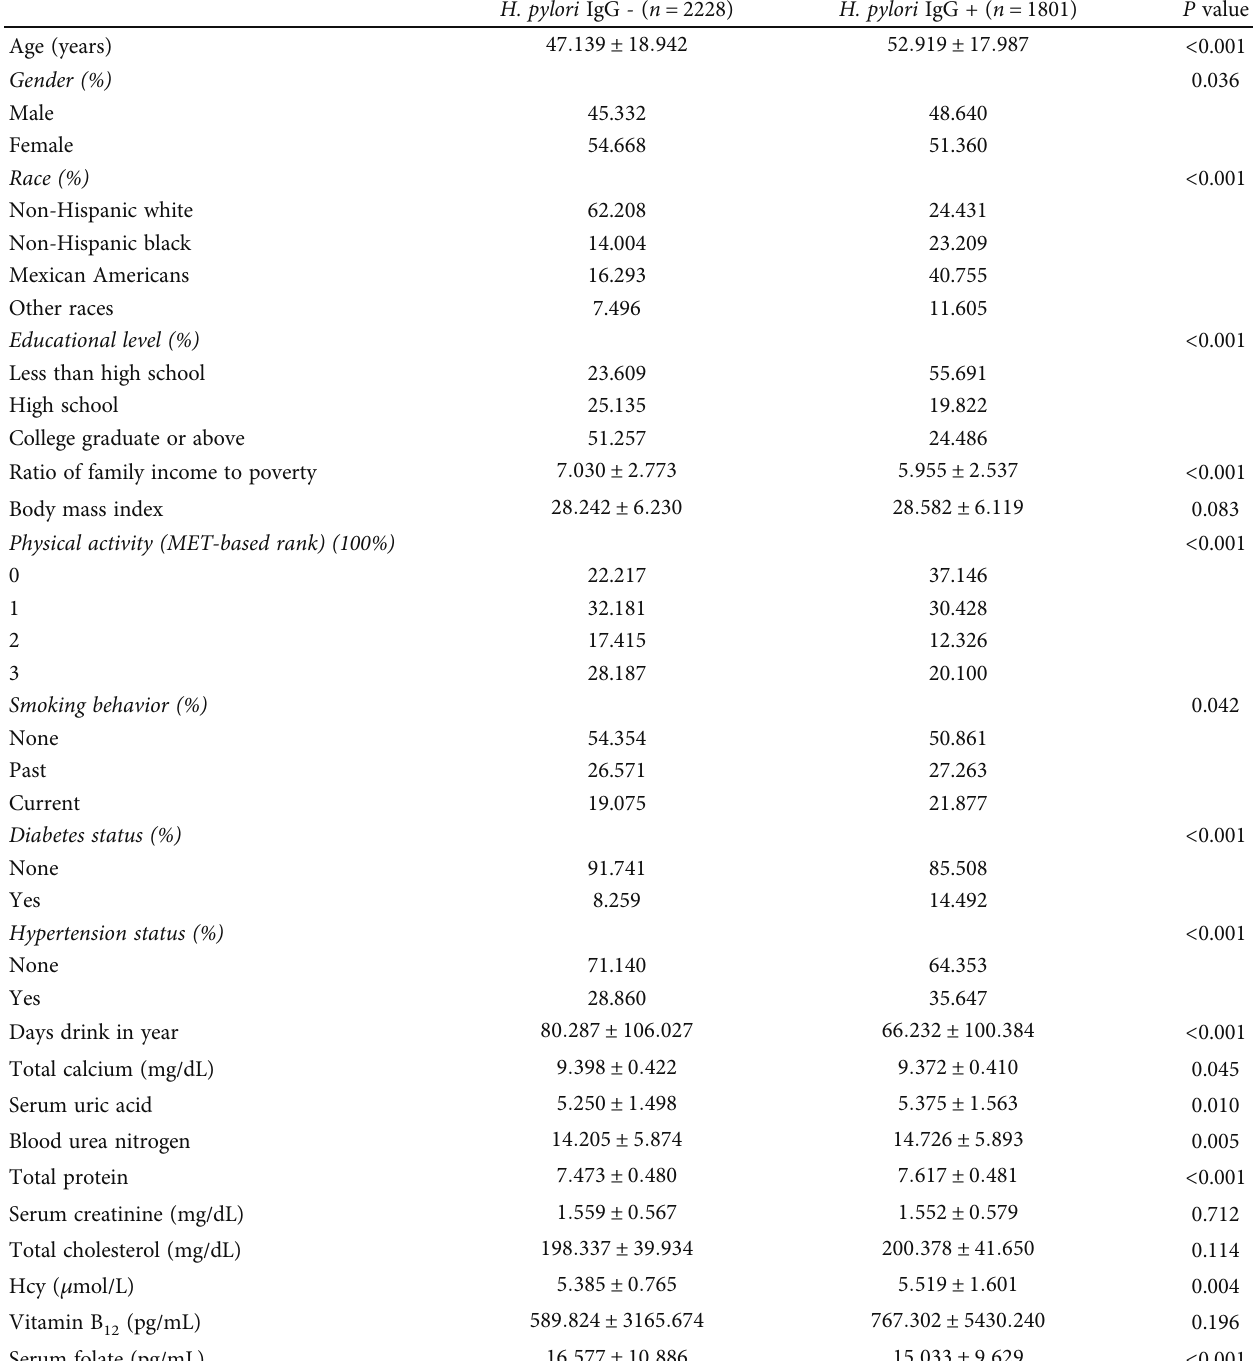
Table 1: Weighted characteristics of the